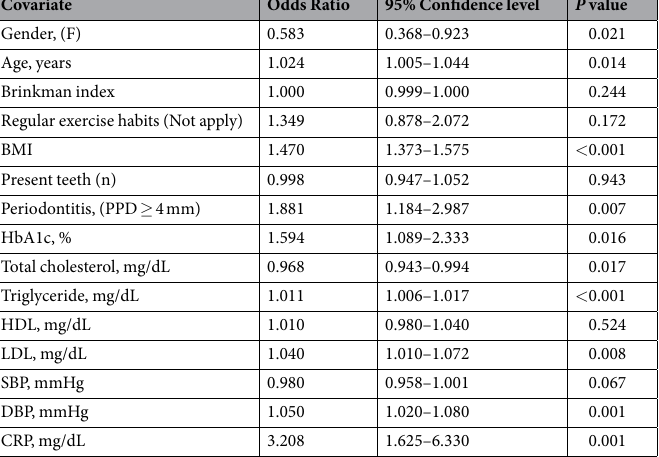
Table 2. Factor associated with NAFLD in Study Populations by Multivariate Logistic Regression Analysis. Abbreviations: NALFD, non-alcoholic fatty liver disease; F, Female; BMI, body mass index; WC, waist circumference; PPD, probing pocket depth; HbA1c, hemoglobin A1c; HDL, high-density lipoprotein; LDL, low- density lipoprotein; SBP, systolic blood pressure; DBP, diastolic blood pressure; CRP, C-reactive